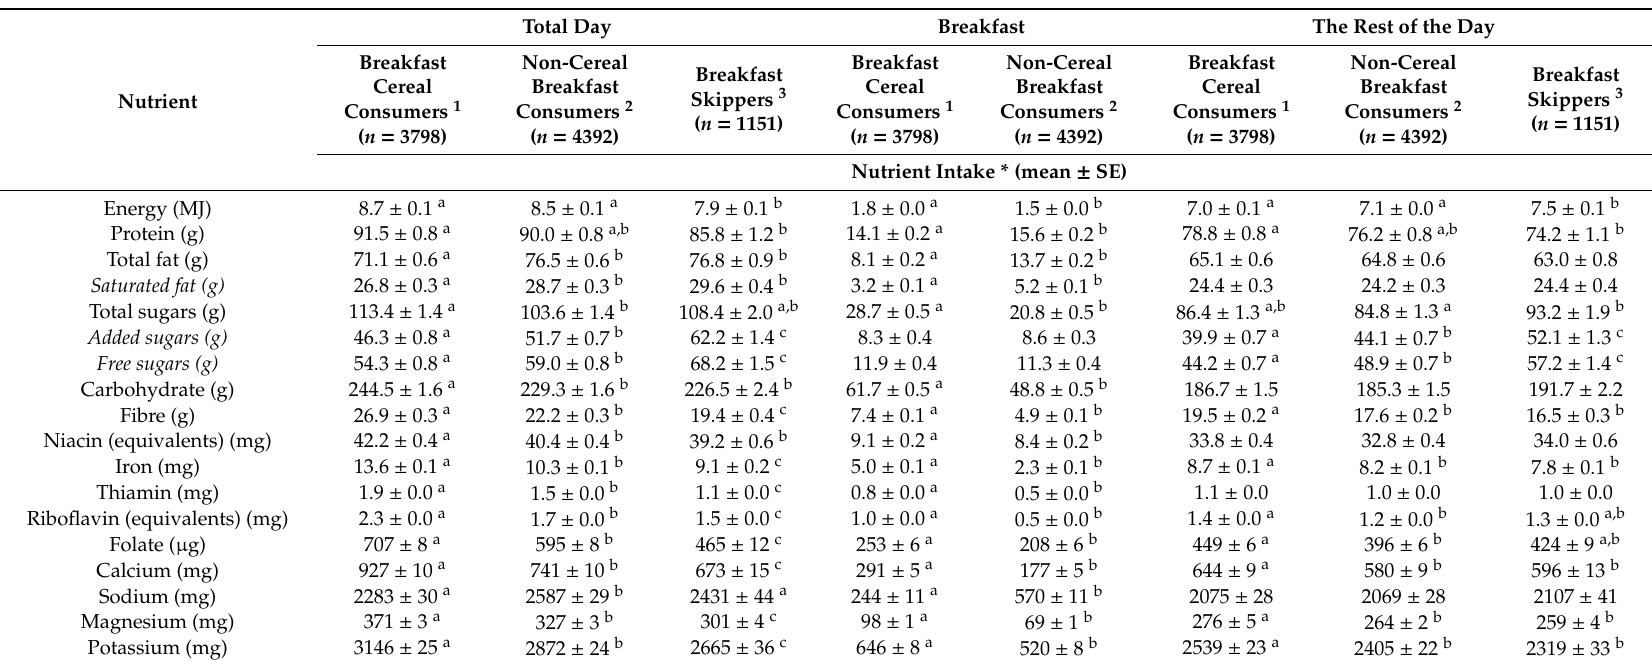
Table 4. Total daily energy and nutrient intake at breakfast, the rest of the day, and the total day by breakfast consumer